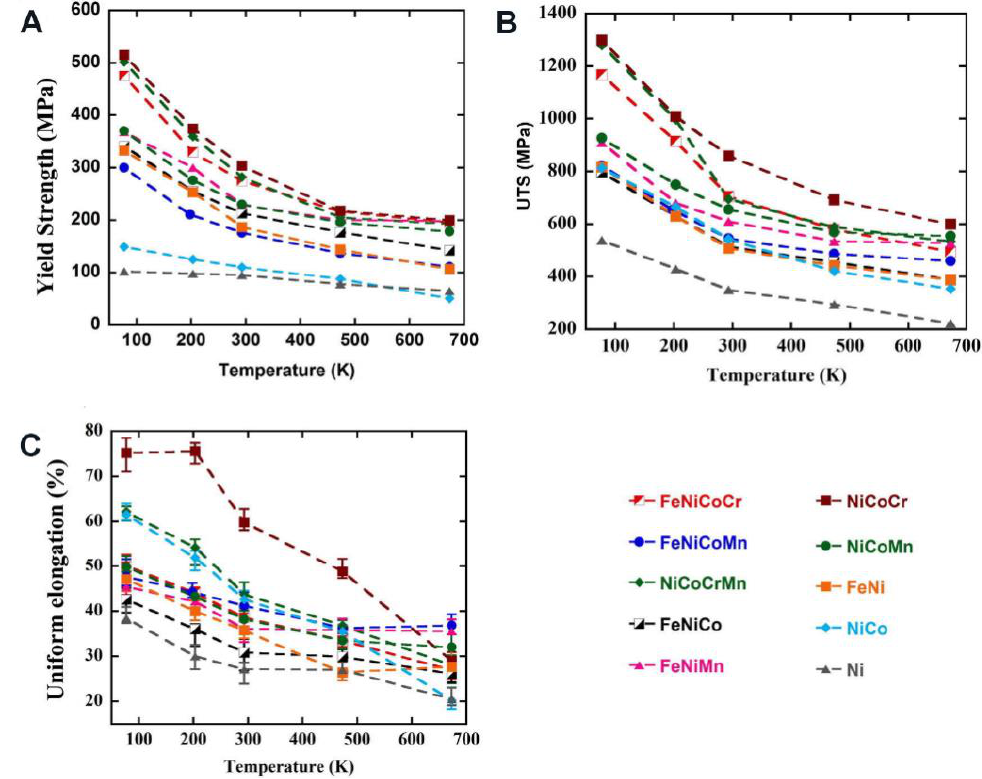
Figure 3. Temperature dependence of ( A ) yield stress, ( B ) ultimate tensile stress and ( C ) uniform elongation to fracture for equal atomic alloys and Ni, reprinted with permission from Ref. [27].